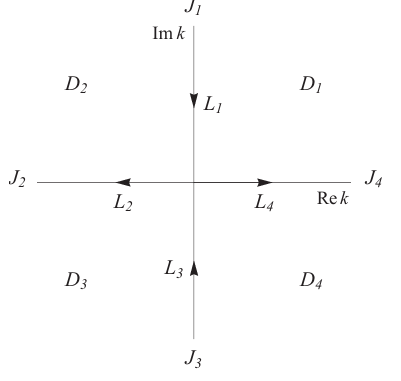
Figure 2: The domain D j and the oriented contour L j , j = 1, . . . ,